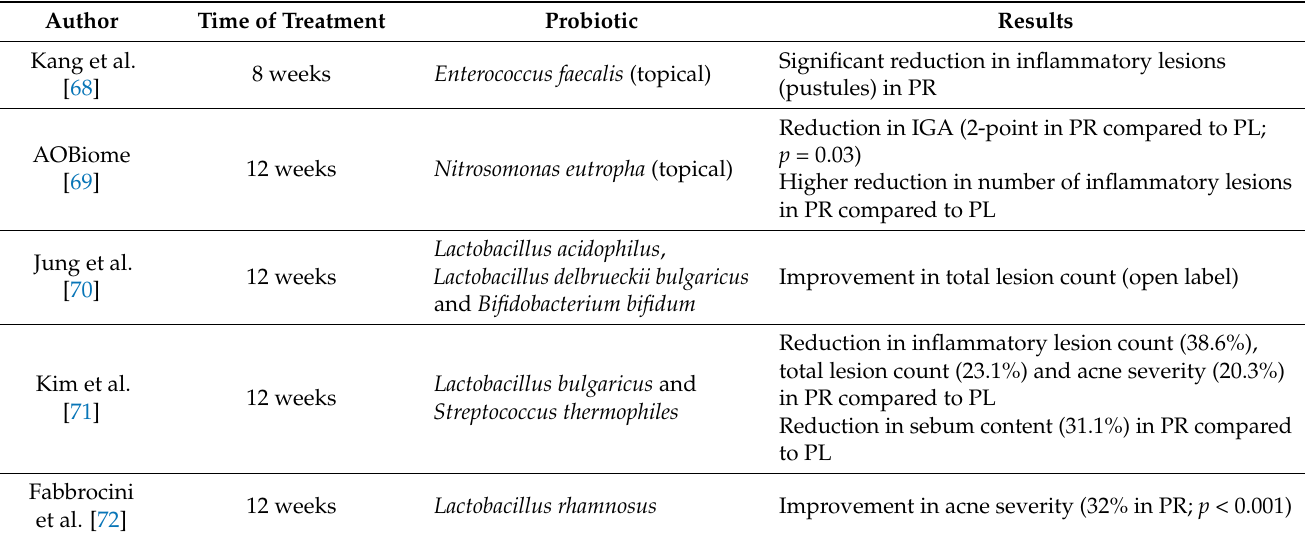
Table 4. Probiotics and